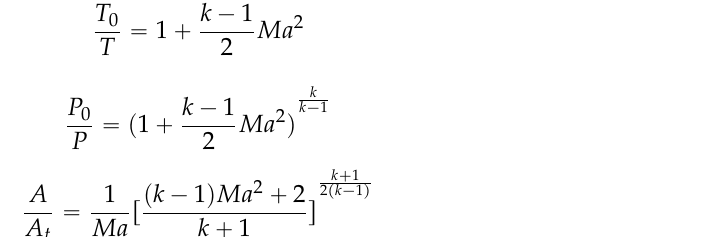
Figure 5. Forced convection coefficient and recovery temperature along the wall. 4. Coupled Nonlinear Contact Simulation Thermo ‐ structural simulation can not only verify the nozzle structure integrity, but also ascertain the weakest parts or points with stress concentration. In this paper, the finite element method is employed to simulate the temperature field in the thermo ‐ structural modules, and the